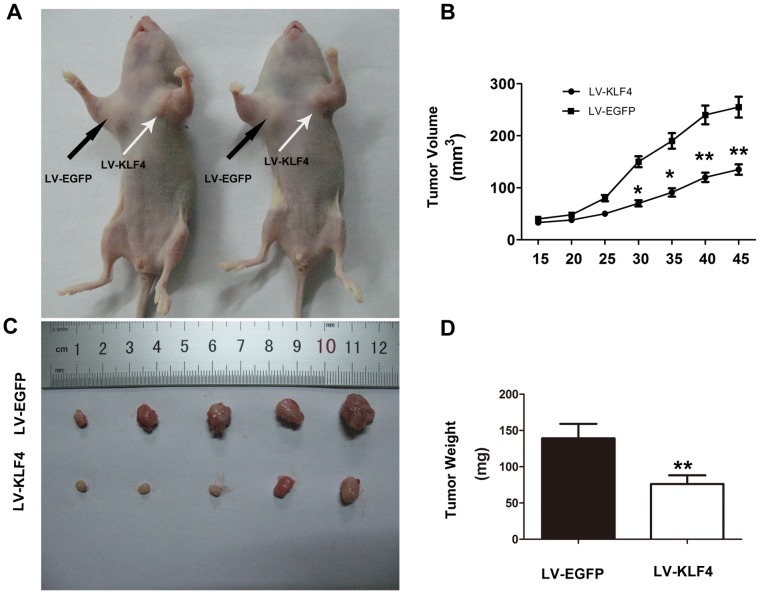
Induced KLF4 expression suppressed tumor growth in vivo.
(A) Representative nude mice showing the different morphologies of the tumors derived from LV-KLF4-transfected 786-O cells (right side) and LV-EGFP-transfected control cells (left side). (B) Tumor growth curve of LV-KLF4- and LV-EGFP-infected 786-O cells in nude mice. Tumor sizes were determined as described in the Materials and Methods (*P<0.05;**P<0.01). (C) Photograph of tumors excised from nude mice 45 days after inoculation of 786-O cells infected with LV-KLF4 (Top) and LV-EGFP (Bottom). (D) The averages of tumor weights derived from the LV-KLF4 group were significantly lower than those from the LV-EGFP group when the nude mice were sacrificed on day 45 after injection. The data shown are mean ± SD (**P<0.01).